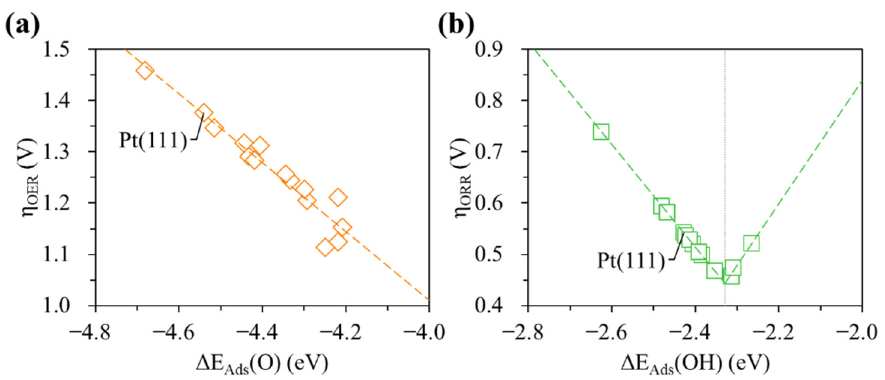
Figure 3. Relation between OER/ORR overpotential and adsorption energy of reaction intermediates O ( a ) and OH ( b ). A smaller negative value on the x -axis (to the right) indicates weaker adsorption.